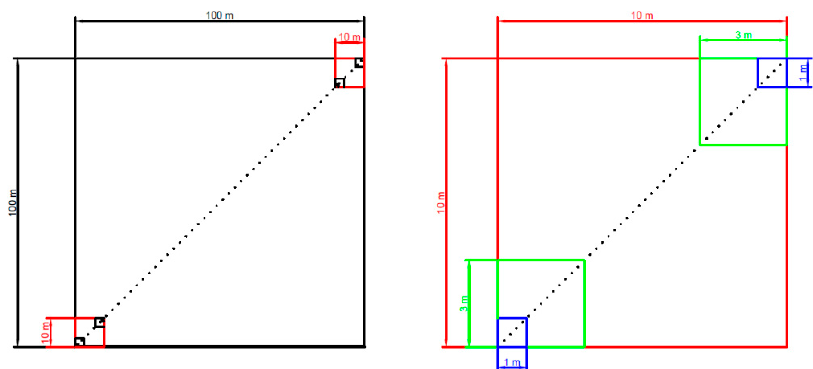
Figure 2. Field sampling design, whereas 100 m × 100 m quadrat in black line was the permanent sample plot, 10 m × 10 m. Quadrats in red line were tree layer investigation plot, 3 m × 3 m quadrats in green line were shrub layer investigation plot, and 1 m × 1 m quadrats in blue line were herb layer investigation plot.